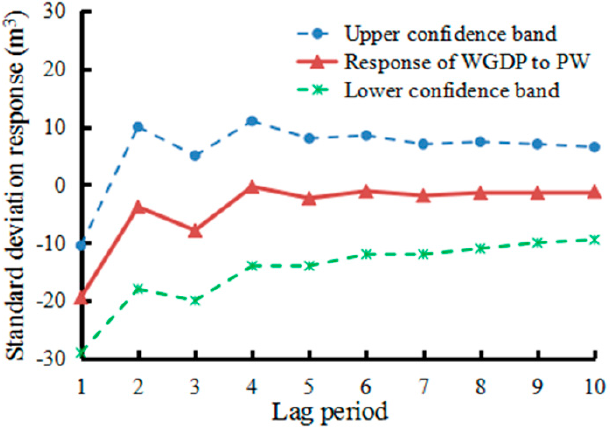
Figure 5. Standard deviation response of WGDP to PW.